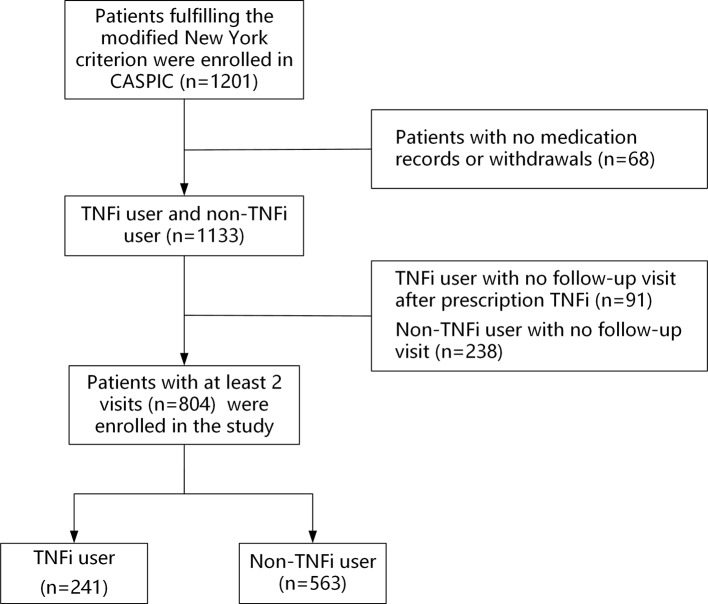
Participant selection flowchart. CASPIC, Chinese Ankylosing Spondylitis Prospective Imaging Cohort; TNFi, tumor necrosis factor inhibitor.